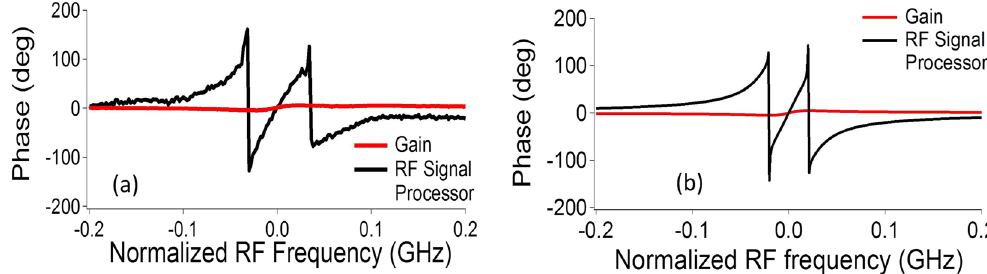
Figure 3. Power-efficient phase shifter. ( a ) The measured S21 phase response of the gain resonance (Red), and the RF processor response (Black). The value of β /2 was kept at 30 MHz and the total pump power was 36 mW, and ( b ) the simulated phase response for the gain (Red) and the RF signal processor (black)